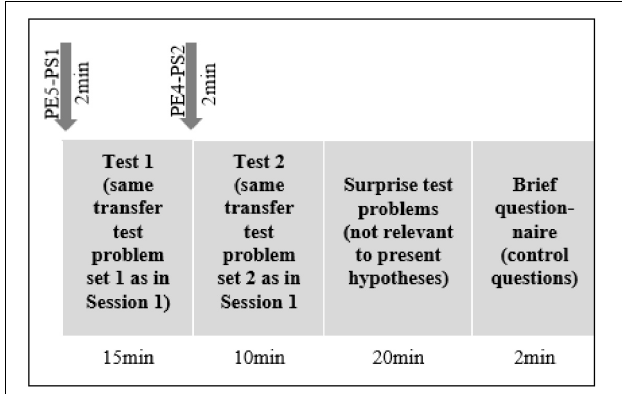
FIGURE 4 | Timeline and schematic design in-class Session Time 2. PE4-PS1, performance expectancy measurement 4 for problem set 1; PE1-PS2, performance expectancy measurement 3 for problem set 2.